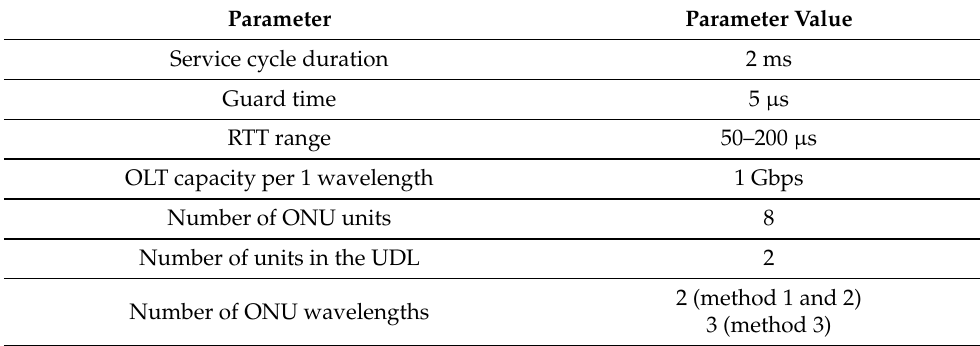
Table 1. Default input parameters in the advanced HPON simulation